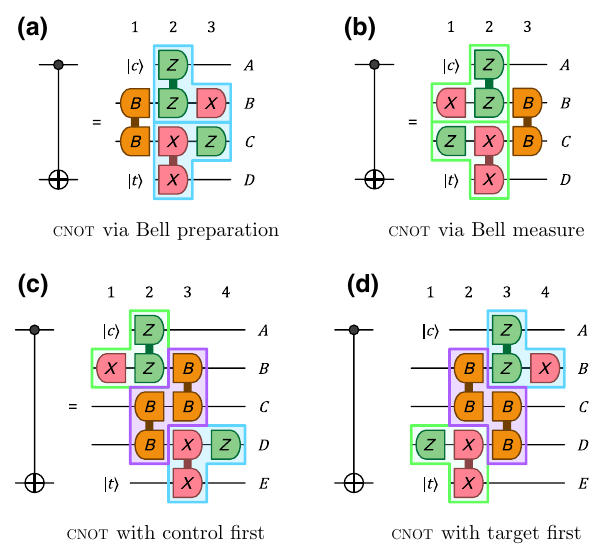
FIG. 19. Various implementations of a CNOT gate with inter- mediate ancilla qubits and Bell operations. In particular, we are able to apply the control and the target either before (green) or after (teal) Bell preparation and measurement steps, while keeping the depth at 2.